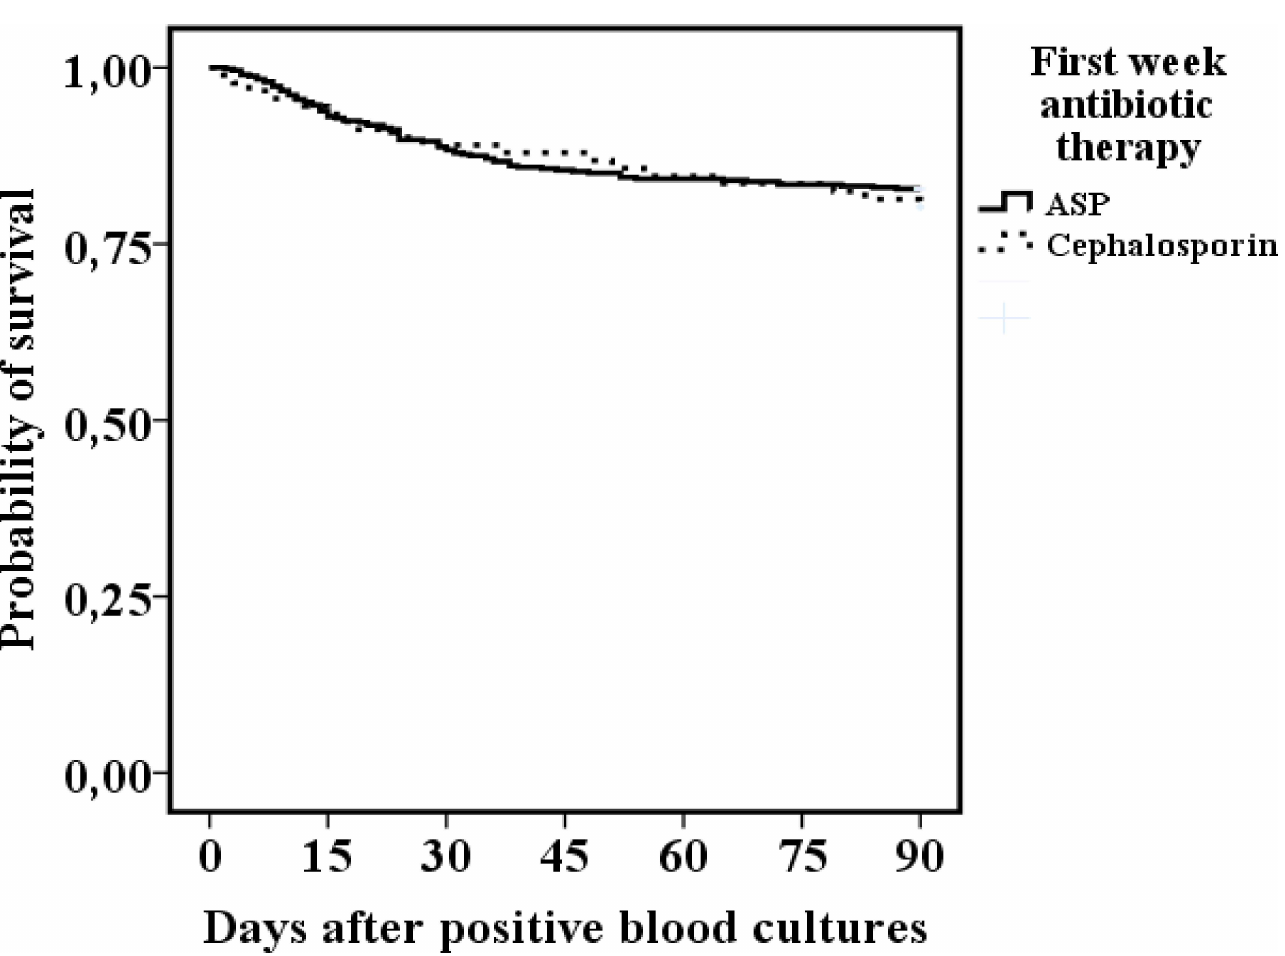
Fig 2. Kaplan-Meier interpretation of 90 days outcome in 580 methicillin-sensitive Staphylococcus aureus bacteremia patients receiving either anti-staphylococcal penicillin (ASP, cloxacillin) (n = 488) or cephalosporin (cefuroxime or ceftriaxone) (n = 92) as first week antibiotic treatment after positive blood cultures. Log-ranknon-significant.